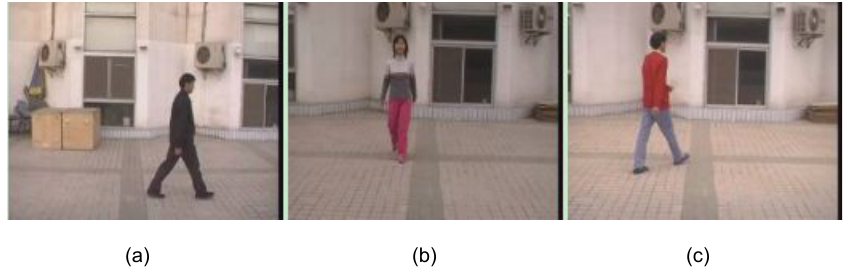
Figure 12. An example of CASIA Dataset A [4]. The images show three different angles of each person’s data. ( a ) Parallel to the image plane, ( b ) 90 degrees, ( c ) 45 degrees.